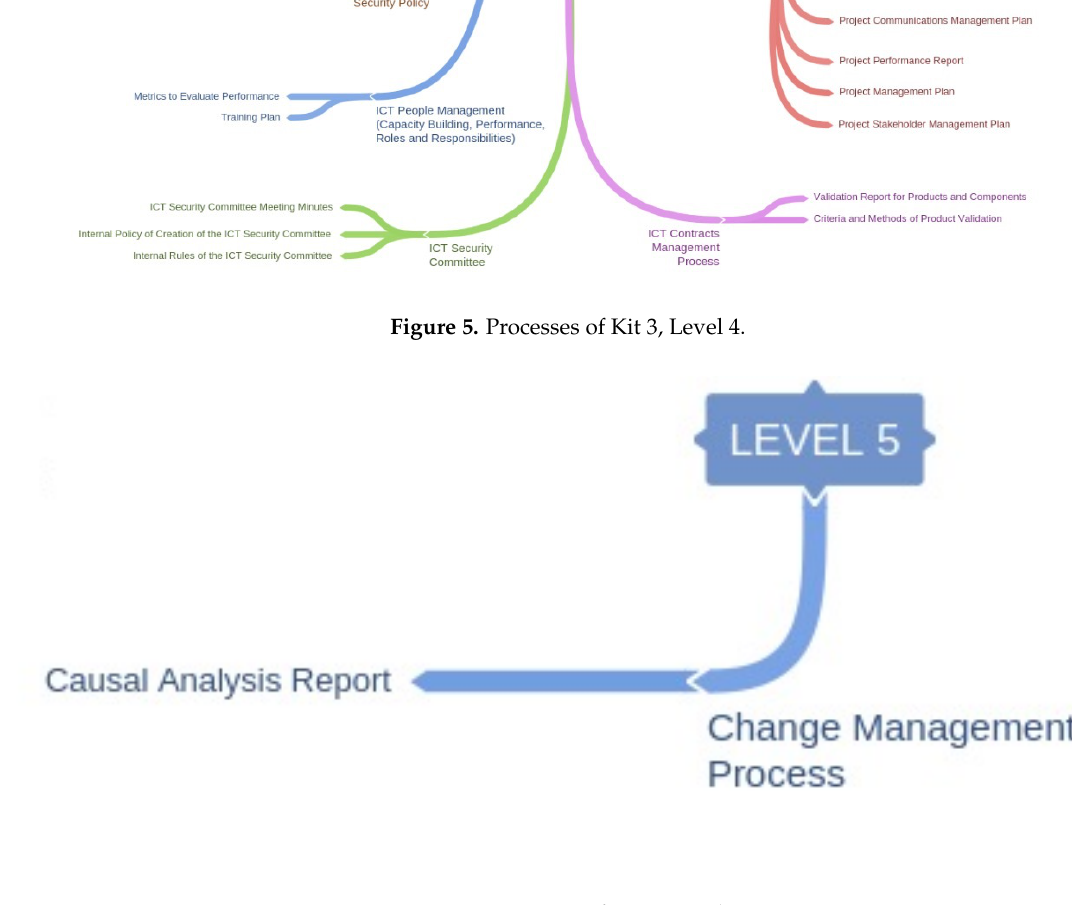
Figure 6. Processes of Kit 3, Level